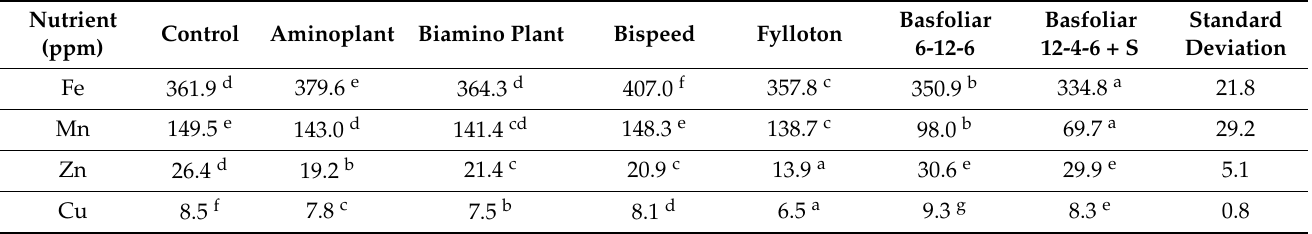
Table 9. Content of micronutrients in leaves of M.9 rootstock stoolings depending on the tested